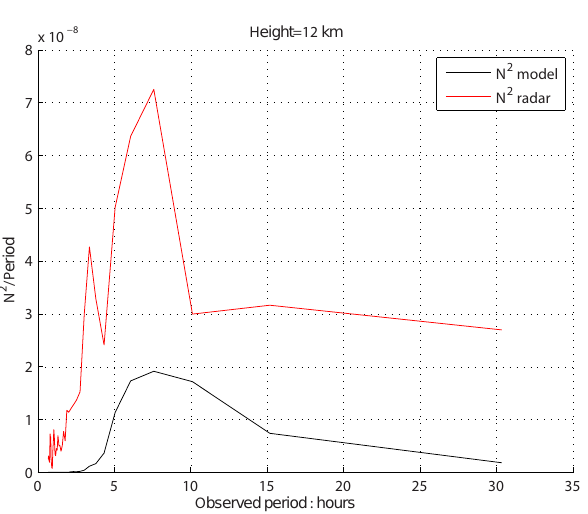
Figure 8. Spectrum of fluctuations of N 2 for time series at 12km height from ESRAD and from the WRF model at the ESRAD loca- tion, from 05:00UTC on 21 February to 09:00UTC on 22 February